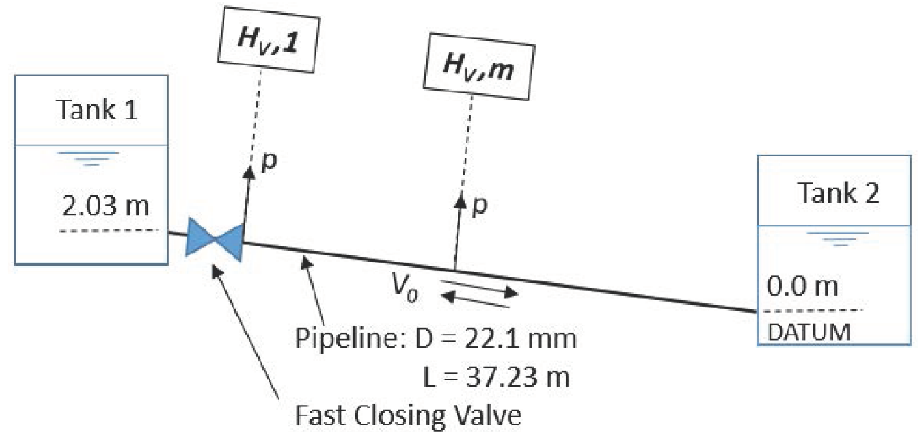
Figure 4. The schematic of the experimental apparatus. Figure adapted from Figure 2 in Ref. [9].